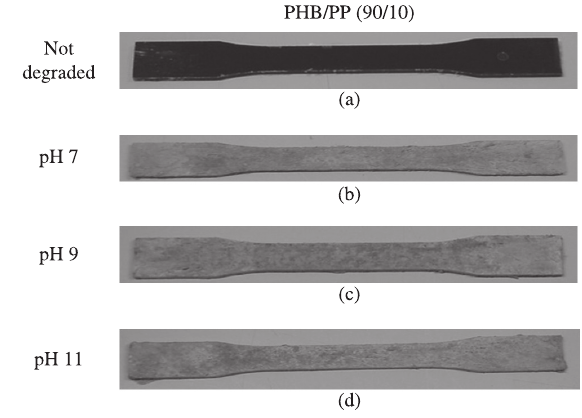
Figure 8. Photographs of the PHB/PP (90/10) specimens: a) before deg- radation tests, and after degradation tests in soil with varying pH; b) pH 7; c) pH 9 ; and d) pH 11.